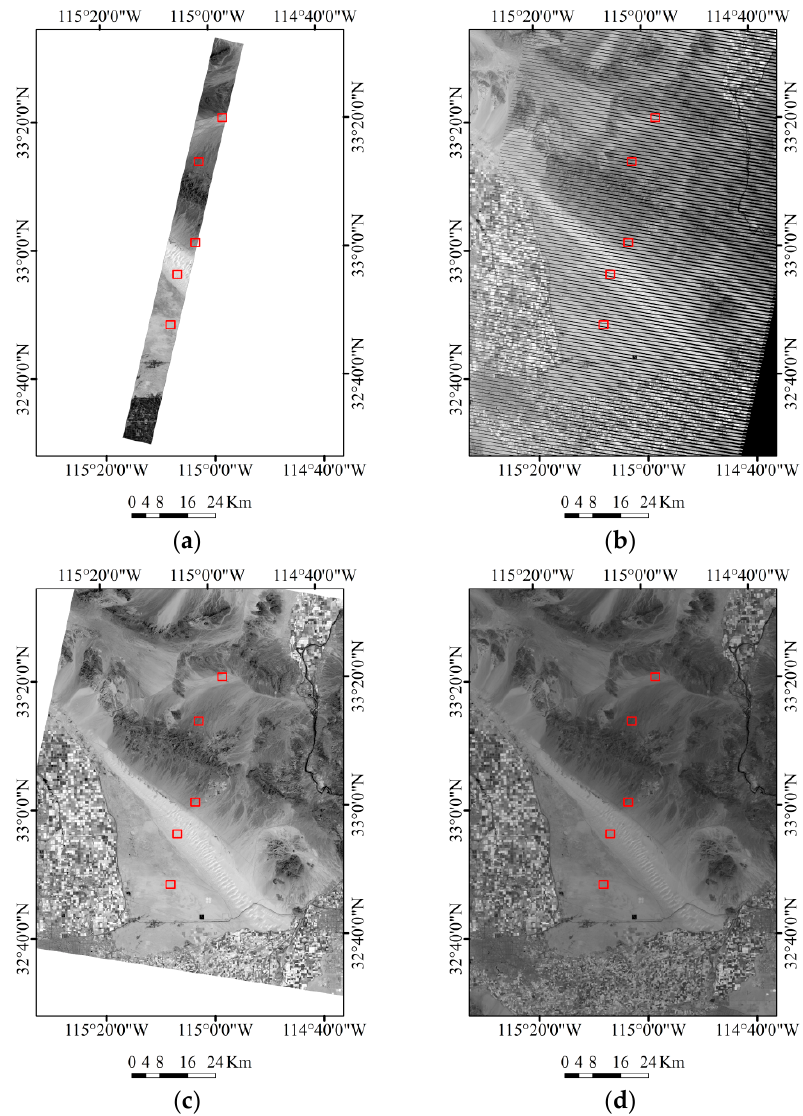
Figure 6. Algodones Dunes image from ( a ) EO-1/Hyperion; ( b ) Landsat-7/EMT+; ( c ) CBERS-4/MUX and ( d ) CBERS-4/WFI. The five red boxes indicate the location of the five ROIs.